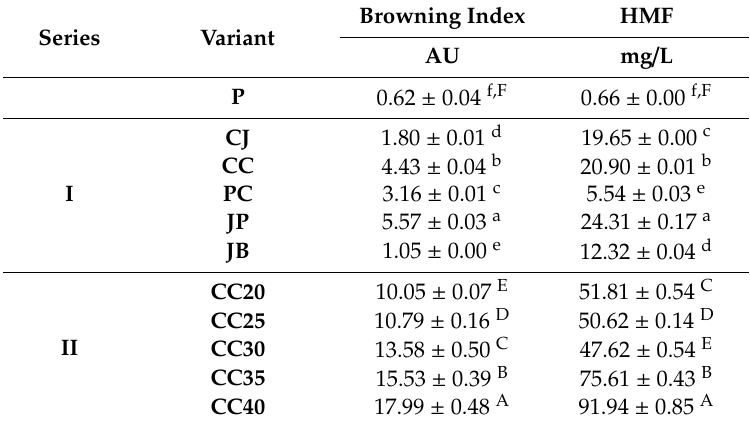
Table 3. The content of 5-hydroxymethylfurfural (HMF) and the browning index of wort produced with the use of di ff erent types and doses of special malts in the wort. Series